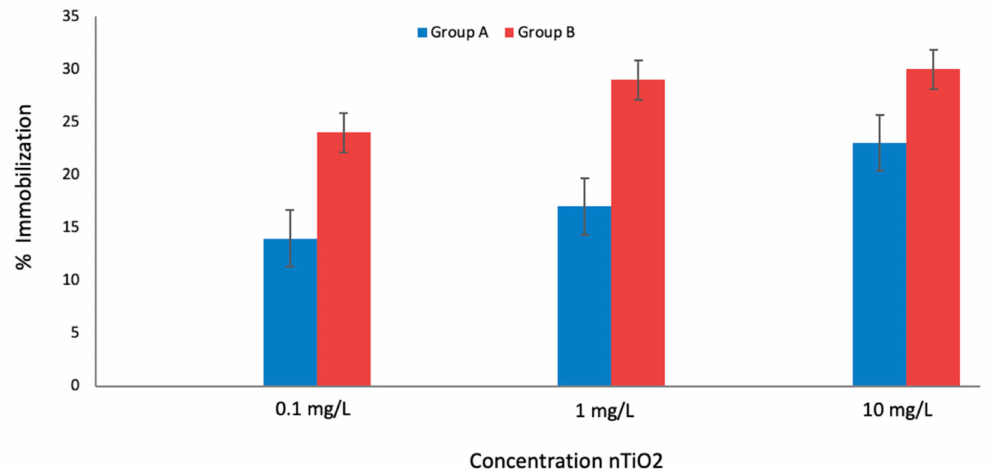
Figure 1. Groups A and B of D. magna exposed at three nTiO 2 concentrations and then incubated 6 h (Group A) or exposed to UV irradiation (Group B). Furthermore, the acute toxicity test was conducted in 78 h total time in both